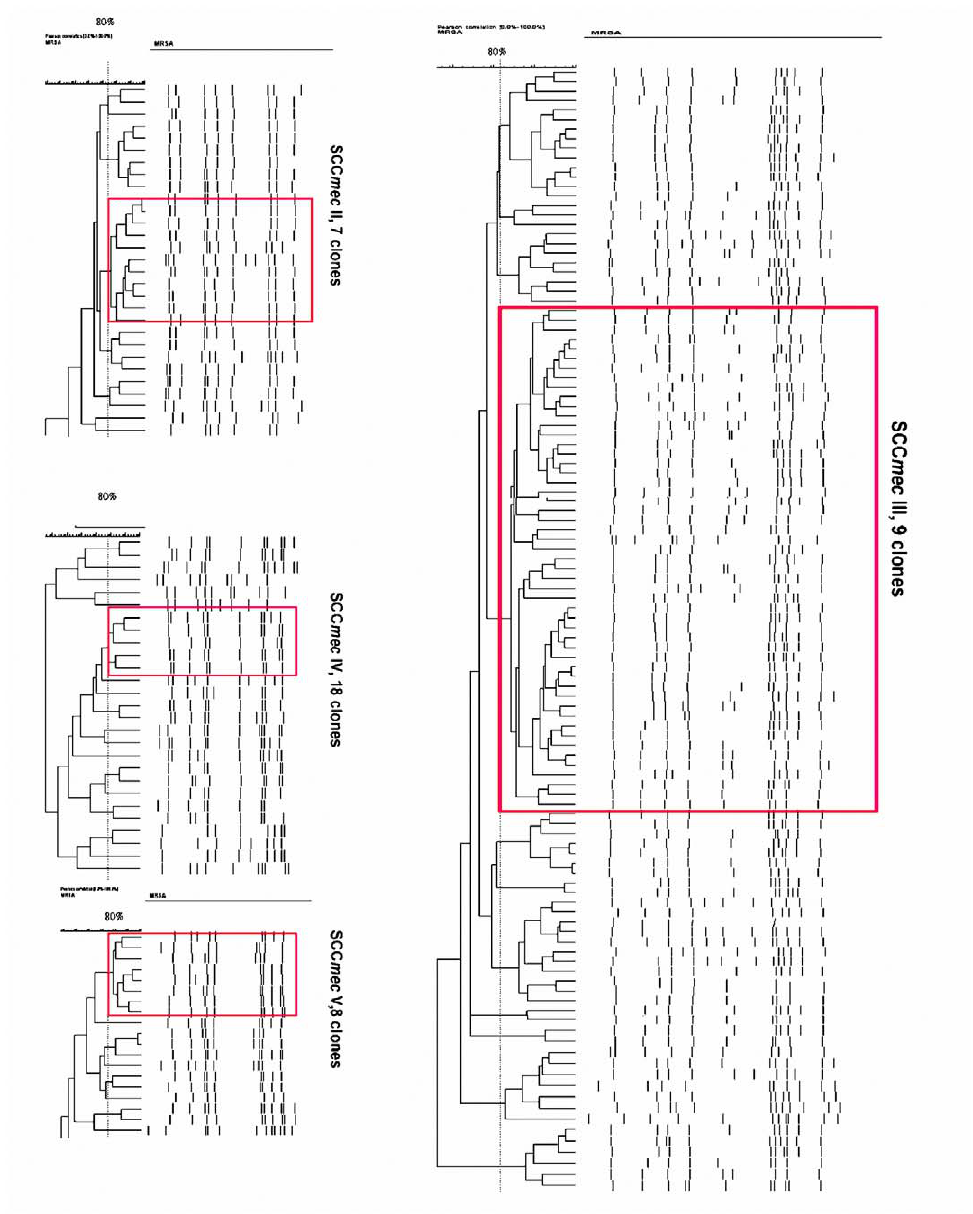
Figure 4. Pulsed-field gel electrophoresis of different SCCmec types; red indicates the major pulsotype.